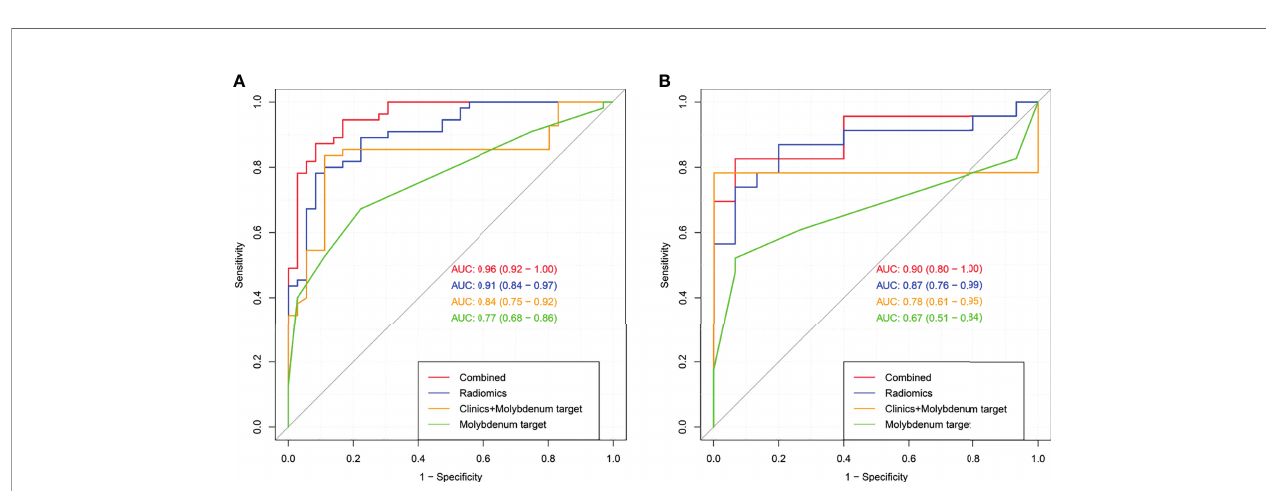
FIGURE 6 | Receiver operating characteristic (ROC) curves for digital mammography, the clinical model, the radiomics signature and the radiomics nomogram in the training set (A) and test set (B) .